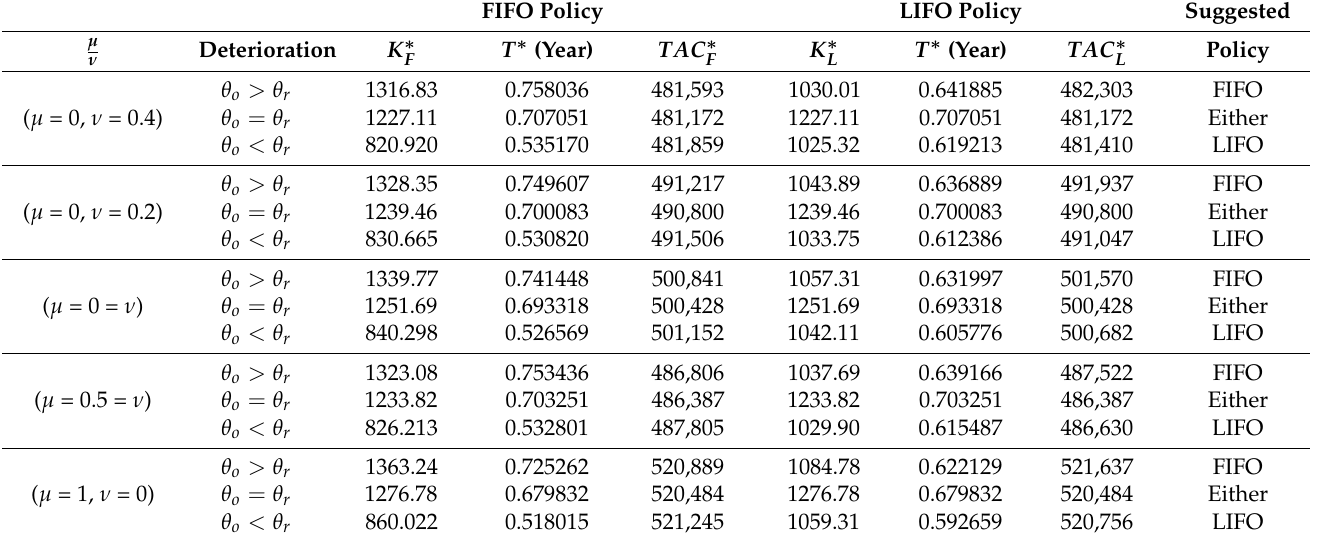
Table 6. Total cost of the two-warehouse system under various values of µ . FIFO Policy LIFO Policy